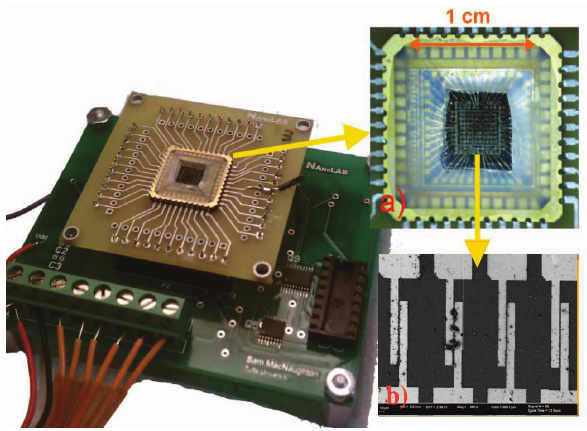
Figure 2. Printed circuit board for selectively addressing each electrode pair for DEP assembly and resistance readout. Inset (a) shows a magnified image of the semi-encapsulated packaged chip. Inset (b) shows a microscope image of a typical site for DEP assembly.